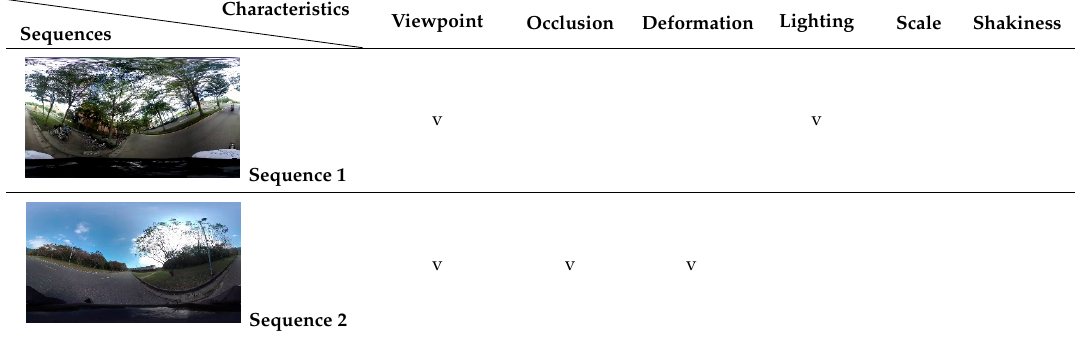
Figure 2. Two ways to set up an omnidirectional camera: ( a ) installed on top of a helmet for ground video capturing, ( b ) attached to a drone for aerial video capturing.